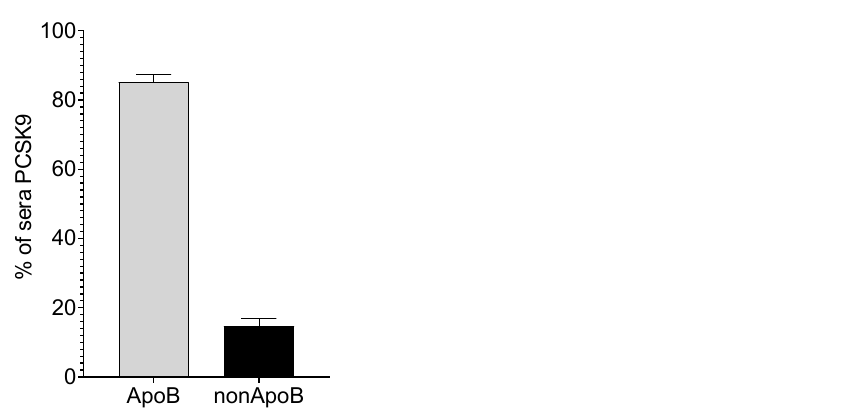
Figure 2. Physical precipitation of ApoB-LPs. PCSK9 was quantified in the supernatant. The PCSK9 content of the ApoB lipoproteins was derived by difference from total plasma PCSK9 values (n = 4). Data were reported as mean + SEM.